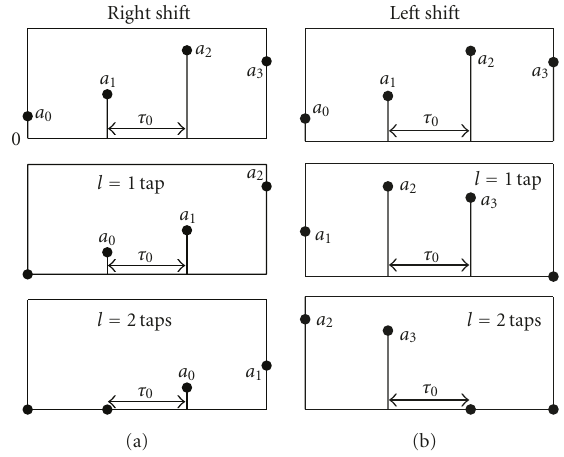
Figure 2: Pattern for the left and right